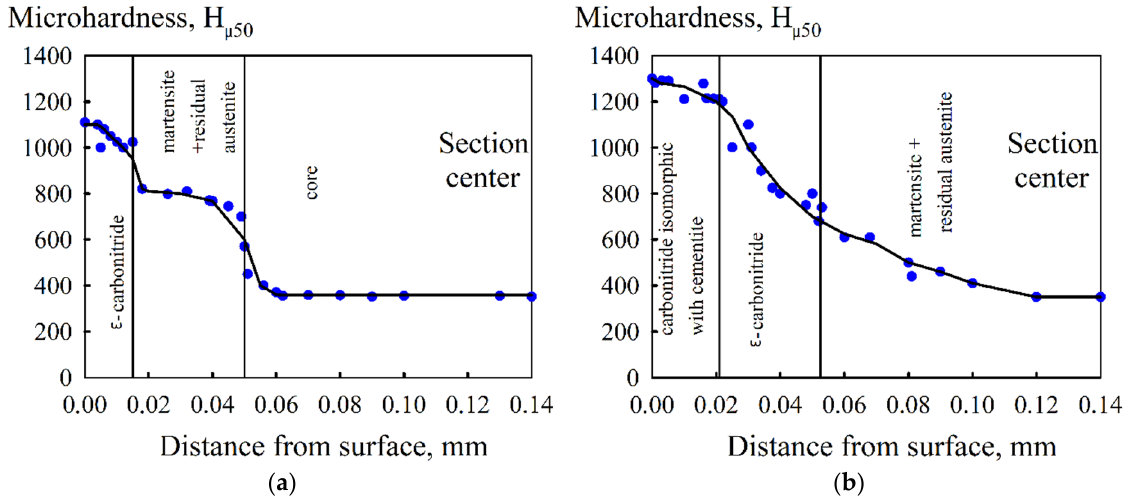
Figure 6. Distribution of microhardness over the diffusion layer cross-section for nitrocarburized steel 60Si2Cr: ( a ) temperature—550 °C, duration—3 h; ( b ) temperature—650 °C, duration—3 h. steel 60Si2Cr: ( a ) temperature—550 ◦ C, duration—3 h; ( b ) temperature—650 ◦ C, duration—3